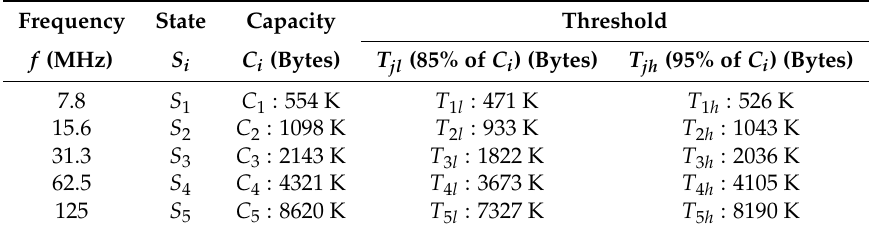
Figure 6. Thresholds of the double-threshold policy. Table 2. Frequency, capacity and threshold mapping table for the double-threshold policy (DTP).